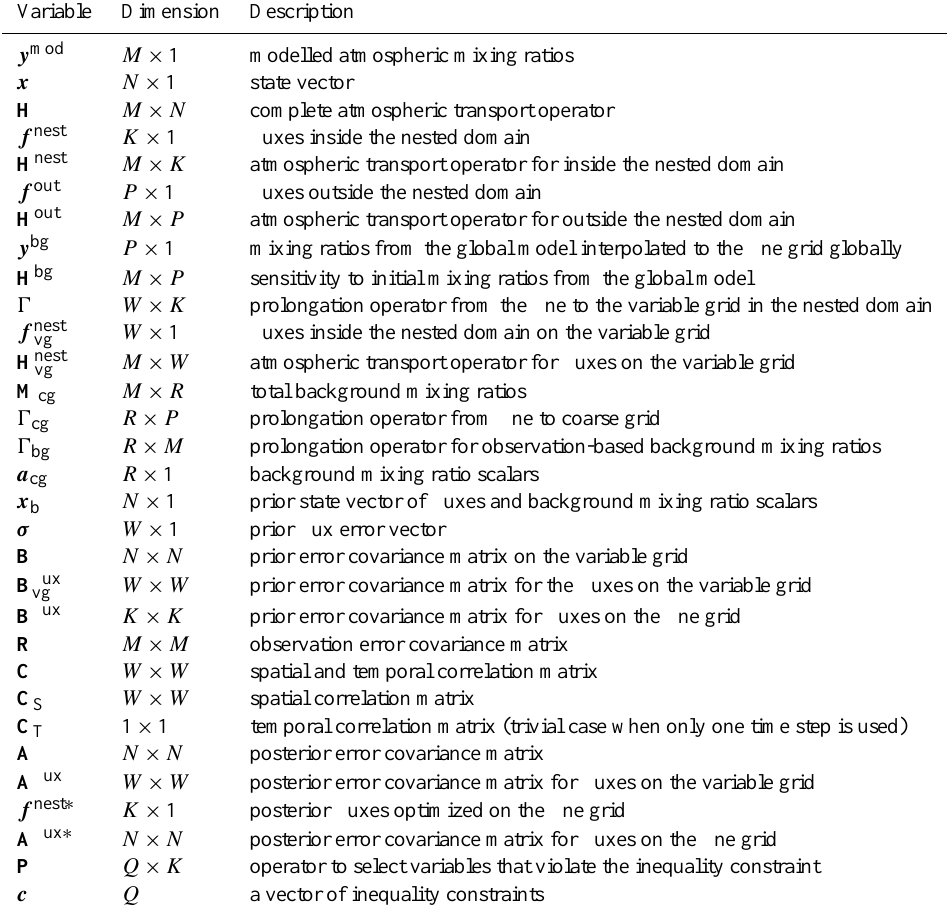
Table 1. Overview of the variables used in this manuscript Variable Dimension Description y mod M × 1 modelled atmospheric mixing ratios N × 1 state vector M × N complete atmospheric transport operator f nest K × 1 fluxes inside the nested domain H nest M × K atmospheric transport operator for inside the nested domain f out P × 1 fluxes outside the nested domain H out M × P atmospheric transport operator for outside the nested domain P × 1 mixing ratios from the global model interpolated to the fine grid globally M × P sensitivity to initial mixing ratios from the global model W × K prolongation operator from the fine to the variable grid in the nested domain W × 1 fluxes inside the nested domain on the variable grid M × W atmospheric transport operator for fluxes on the variable grid M × R total background mixing ratios prolongation operator from fine to coarse grid prolongation operator for observation-based background mixing ratios R × 1 background mixing ratio scalars prior state vector of fluxes and background mixing ratio scalars prior flux error vector prior error covariance matrix on the variable grid prior error covariance matrix for the fluxes on the variable grid prior error covariance matrix for fluxes on the fine grid observation error covariance matrix spatial and temporal correlation matrix spatial correlation matrix temporal correlation matrix (trivial case when only one time step is